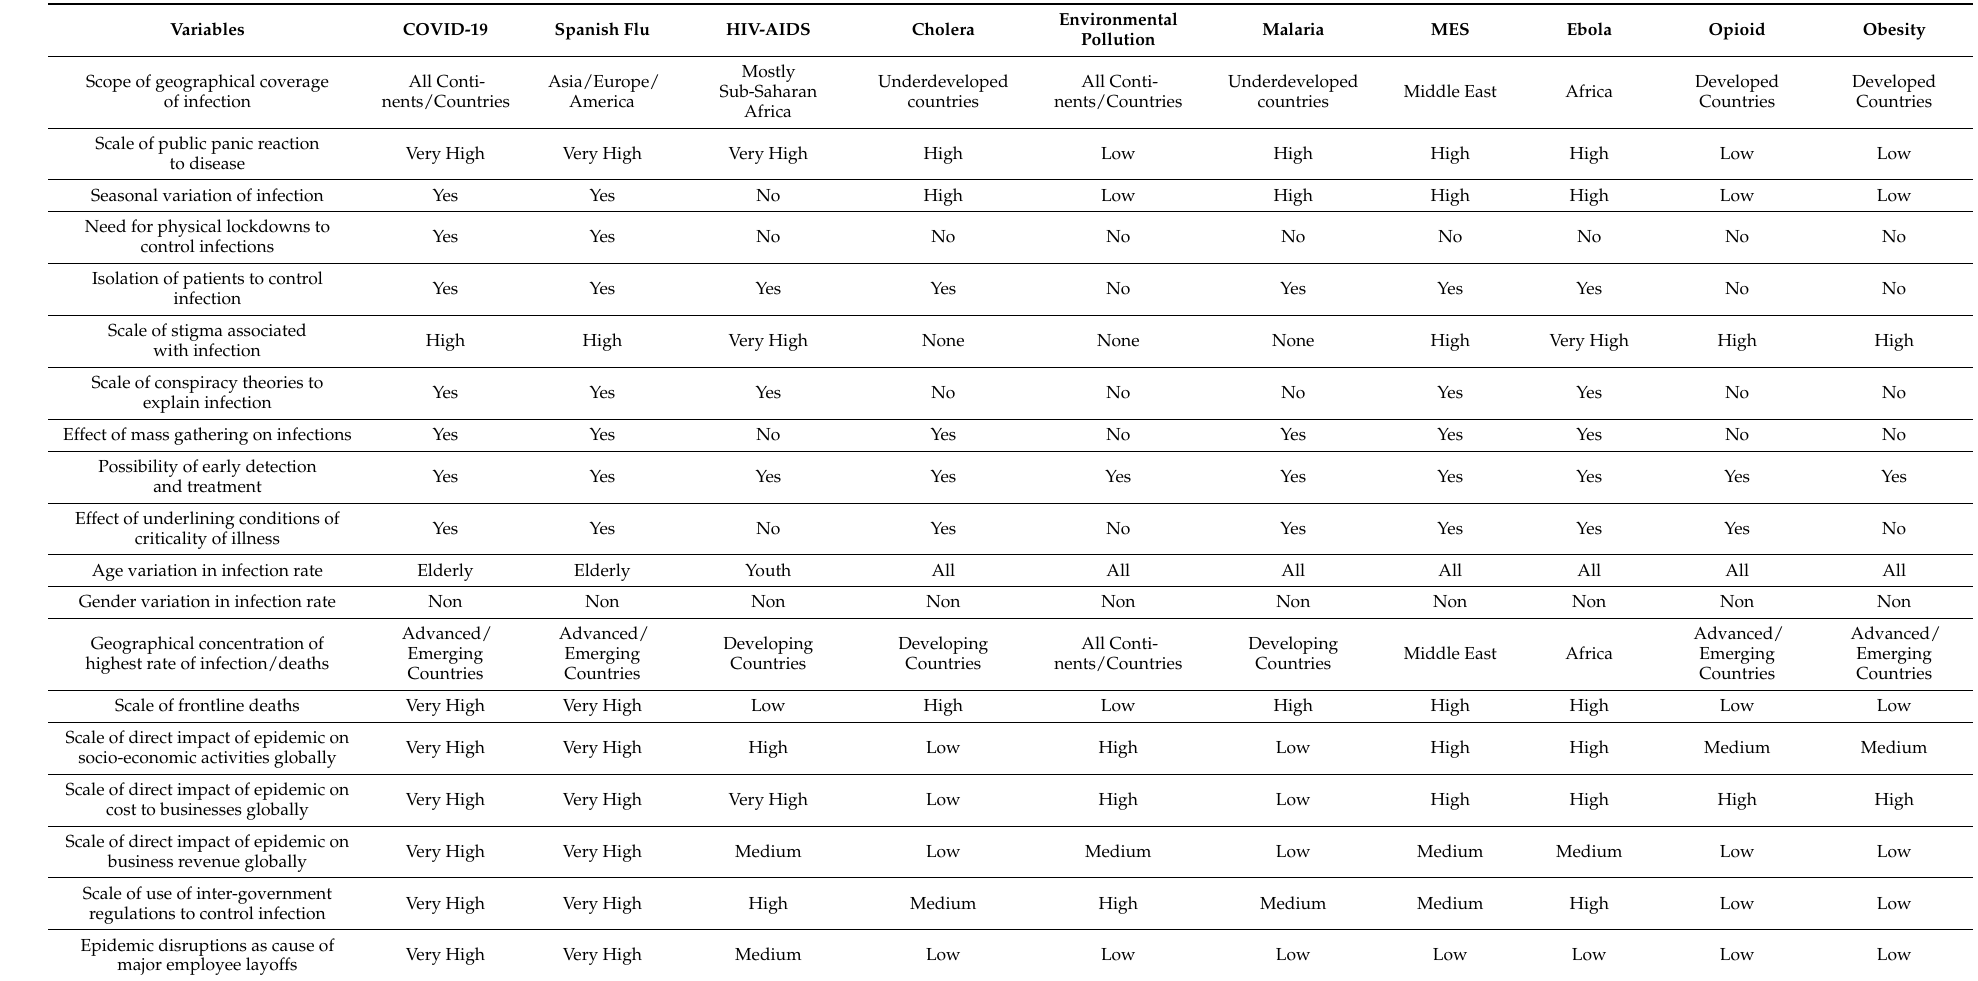
Table 4. Differences and similarities between the global health pandemics that have influenced